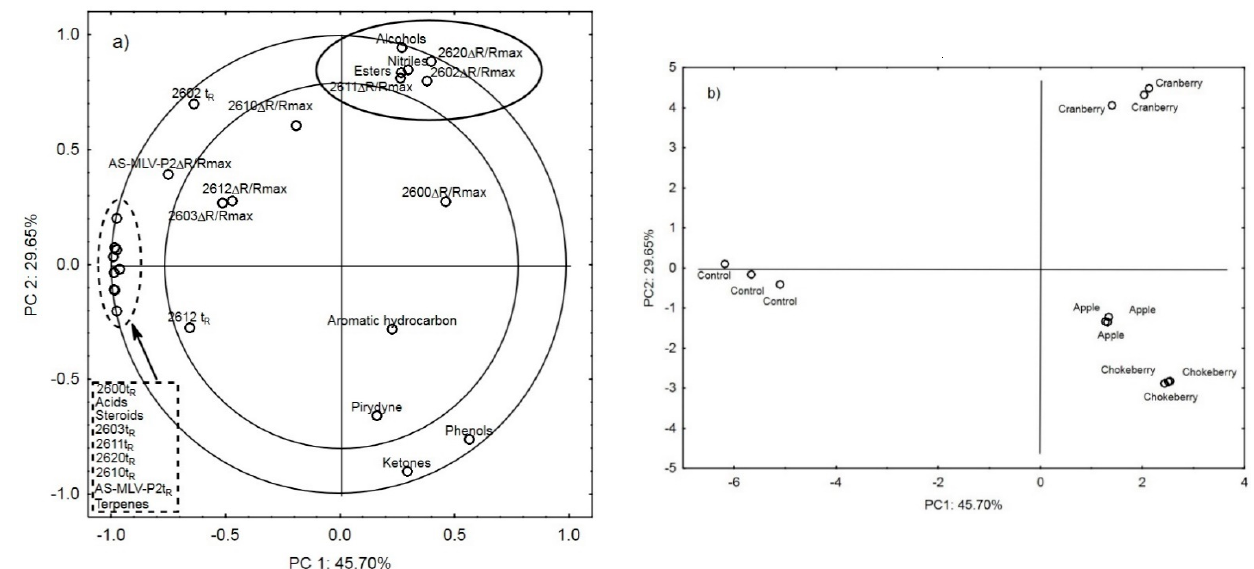
Figure 1. ( a ) Projection of the variables: main chemical compounds and electronic nose responses to the PC1 and PC2 factor plane; ( b ) projection of the cases of supplementing bread with chokeberry fiber, apple fiber, cranberry fiber and for control bread to the PC1 and PC2 factor plane.